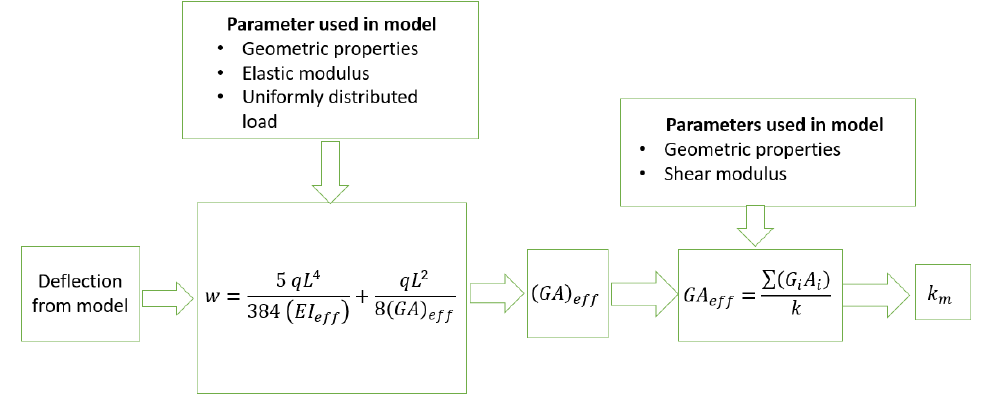
Figure 13. Methodology to determine the shear correcting factor.